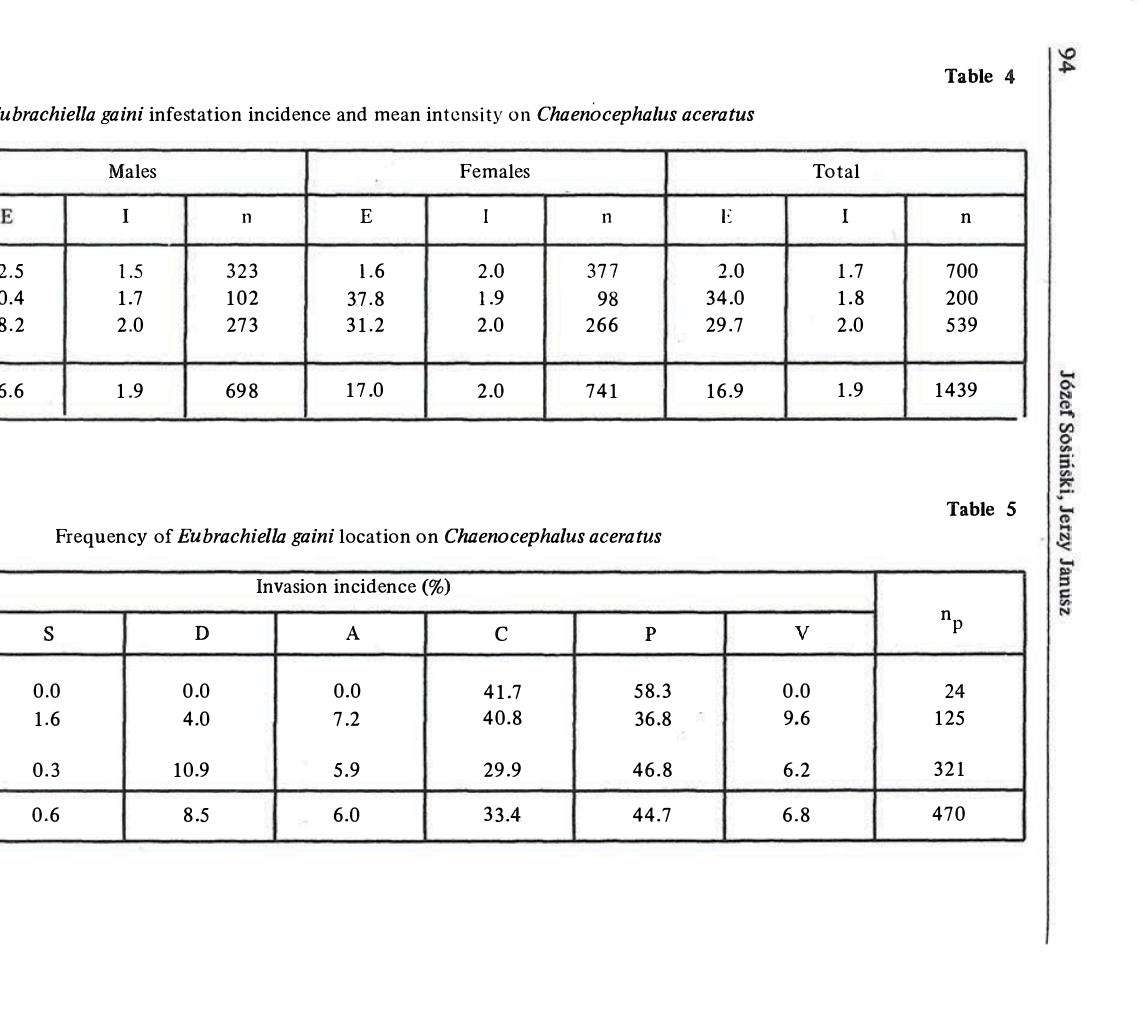
The Eubrachiella gaini infestation incidence and mean intensity on Chaenocephalus aceratus